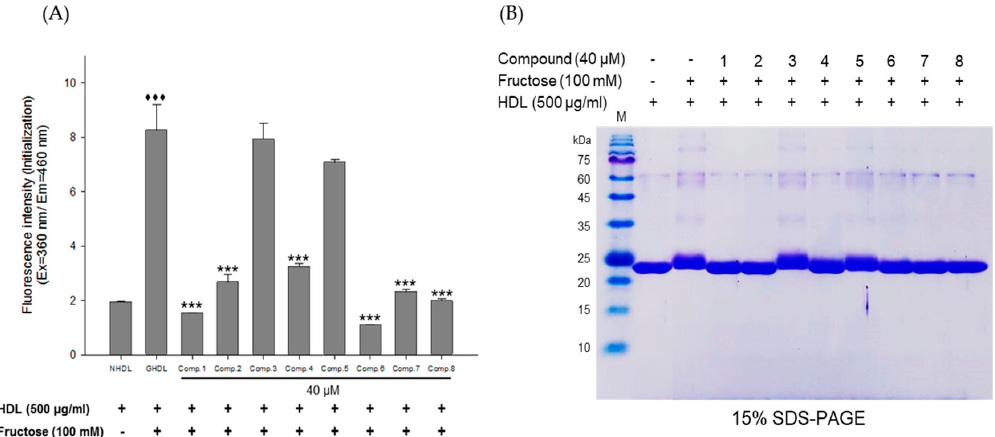
Figure 6. Effects of eight flavonoids from E. koreanum on fructose induced HDL glycation. ( A ) The formation of AGEs was determined by measuring the fluorescence intensity (Ex = 360 nm, Em = 460 nm). ( B ) SDS-PAGE of HDL modified by 100 mM fructose for 72 h in the absence or presence of the eight flavonoids (final concentration, 40 μ M). These data are expressed as mean ± SD of three independent experiments. ♦♦♦ , p < 0.001 vs. NHDL (native HDL); ***, p < 0.001 vs. GHDL (glycated HDL).